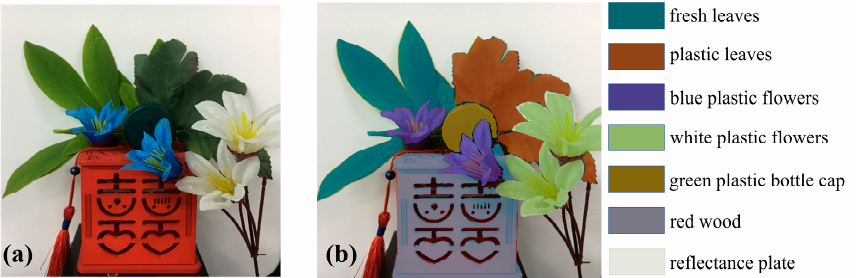
Figure 2. A selection of the objects made of materials likely to be present at realistic scenarios. ( a ) Photo of the objects. ( b ) Positions of different objects representing by different colors.